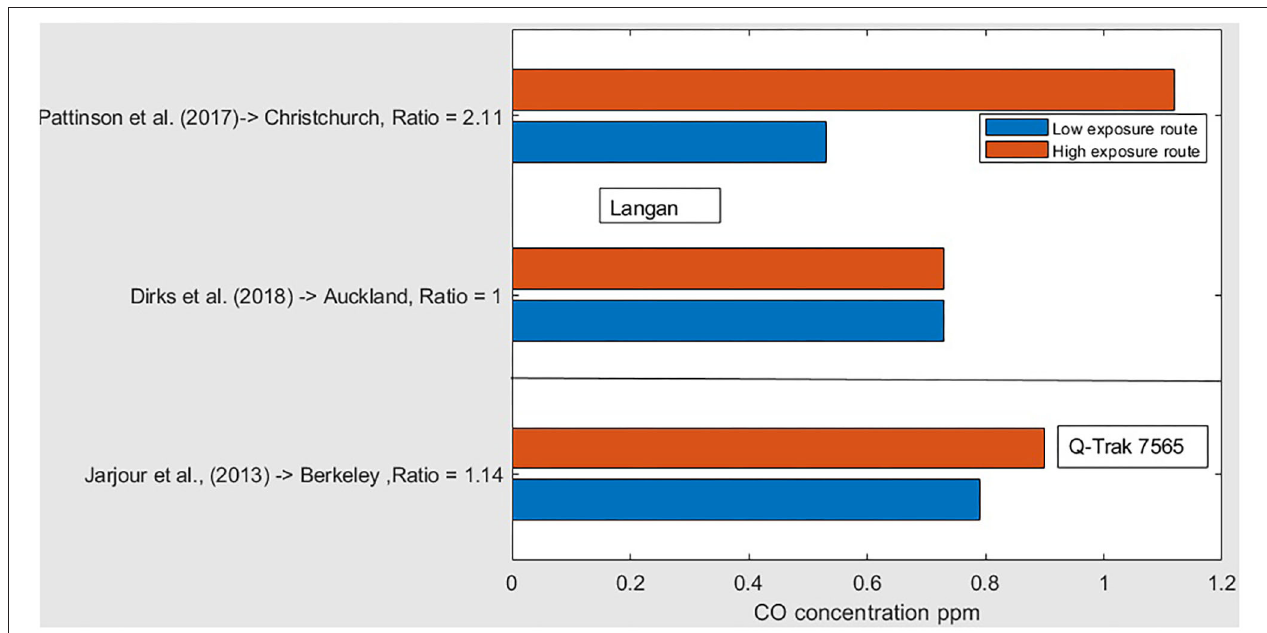
FIGURE 4 | Comparison of concentration of CO in low and high exposure route in the studies. High exposure is in orange color and the low exposure in blue. The ratio is the mean of high exposure divided to the low exposure route.